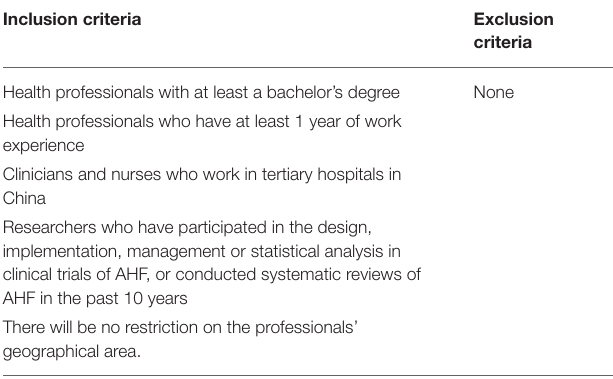
TABLE 3 | The inclusion and exclusion criteria for semi-structured interview. Inclusion criteria